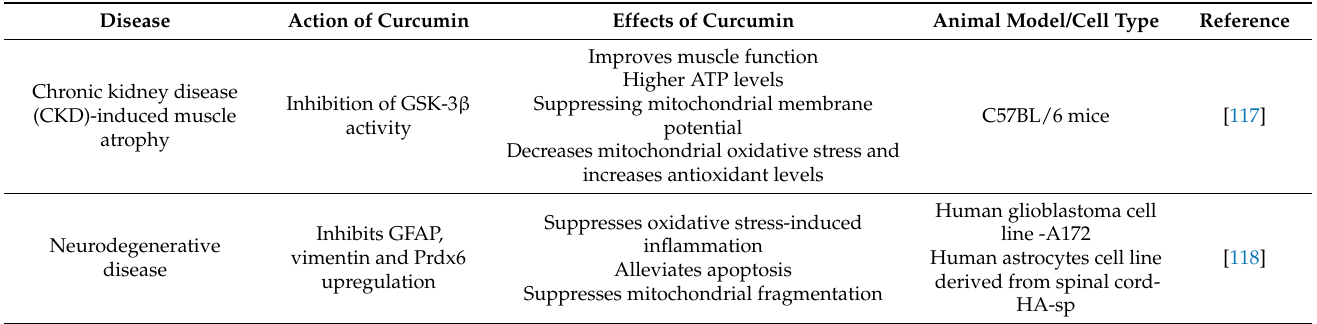
Table 2. The role of curcumin in alleviating mitochondrial dysfunction in different